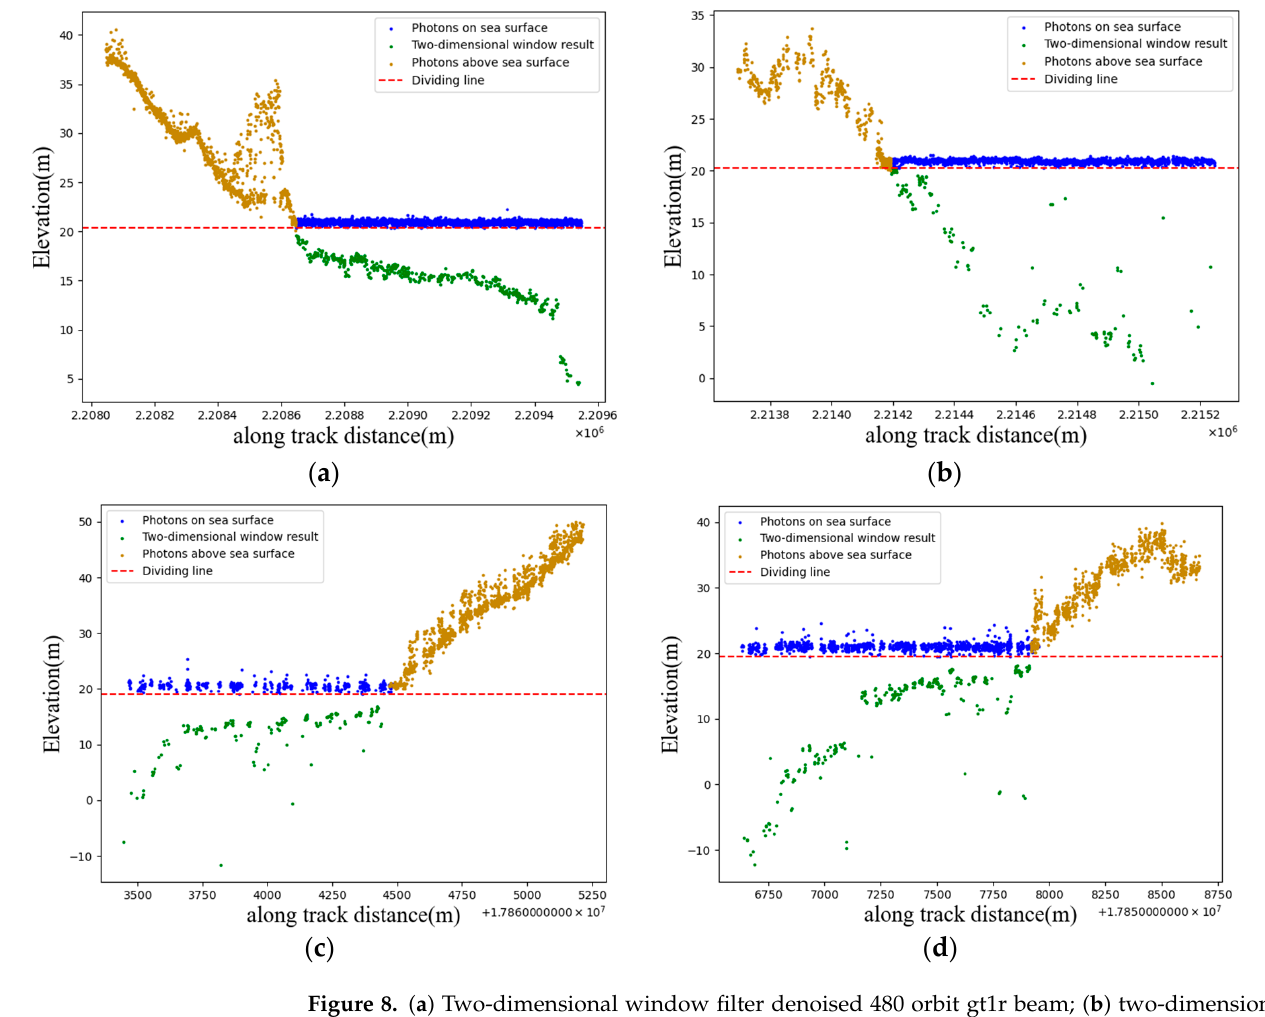
( d ) Figure 7. ( a ) DBSCAN denoised 480 orbit gt1r beam after parameter adjustment (eps = 4, Mintpts = 3); ( b ) DBSCAN denoised 480 orbit gt2r beam after parameter adjustment (eps = 3, Mintpts = 2); ( c ) DBSCAN denoised 1036 orbit gt2r beam after parameter adjustment (eps = 4, Mintpts = 4); ( d ) DBSCAN denoised 1036 orbit gt1r beam after parameter adjustment (eps = 3, Mintpts = 4). 4.2. Photon Denoising Based on the Two-Dimensional Window Filter Since the spot size of ICESat-2 is 17 m and a maximum of 15 geolocation photons can be observed per meter in water depth less than 1 m [25], the length of the window was set